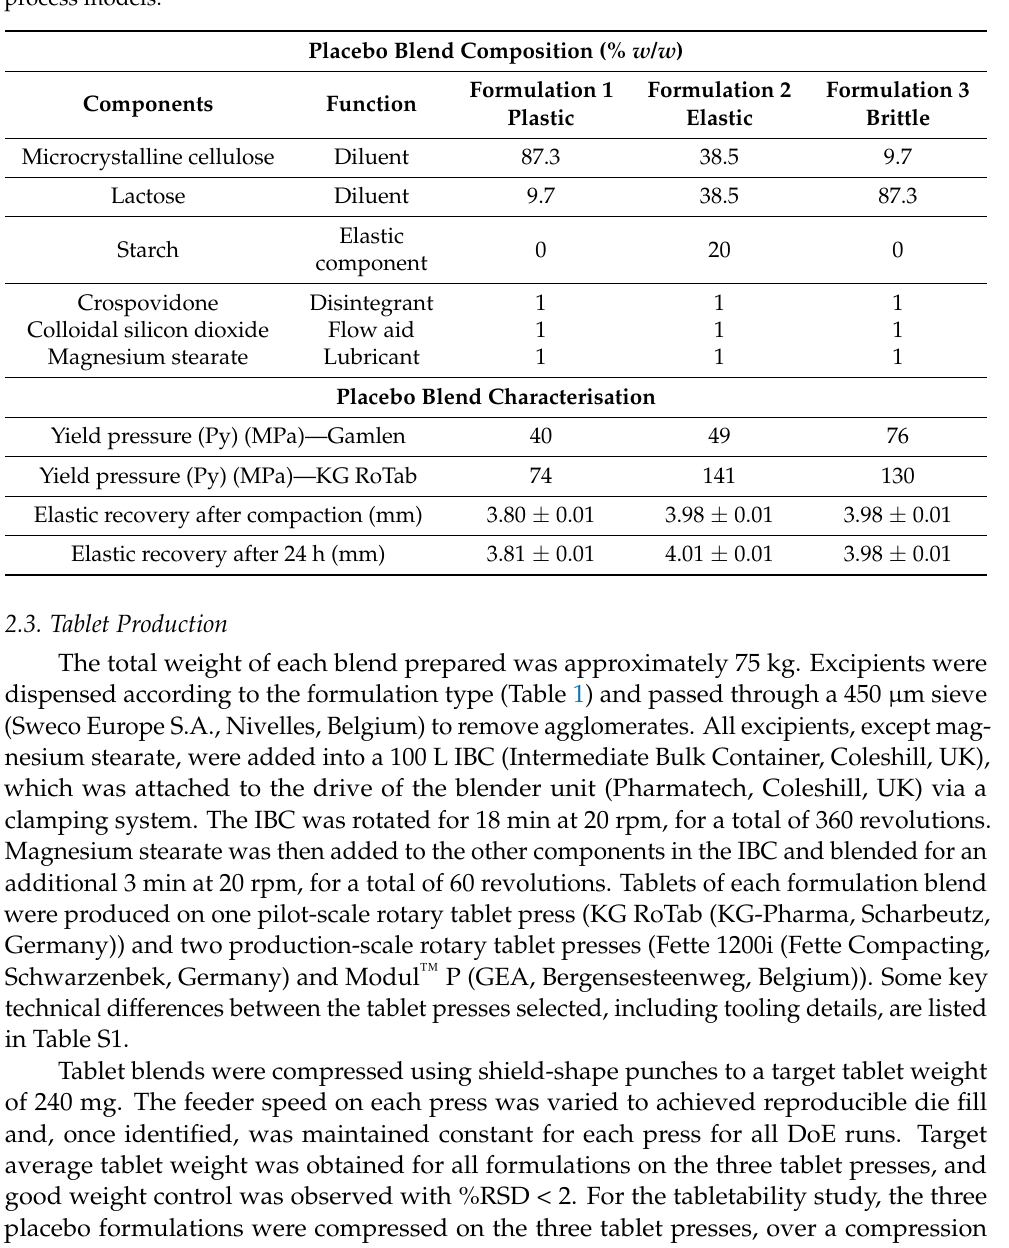
Table 1. Composition, yield pressure and elastic recovery of placebo blends used to develop the process